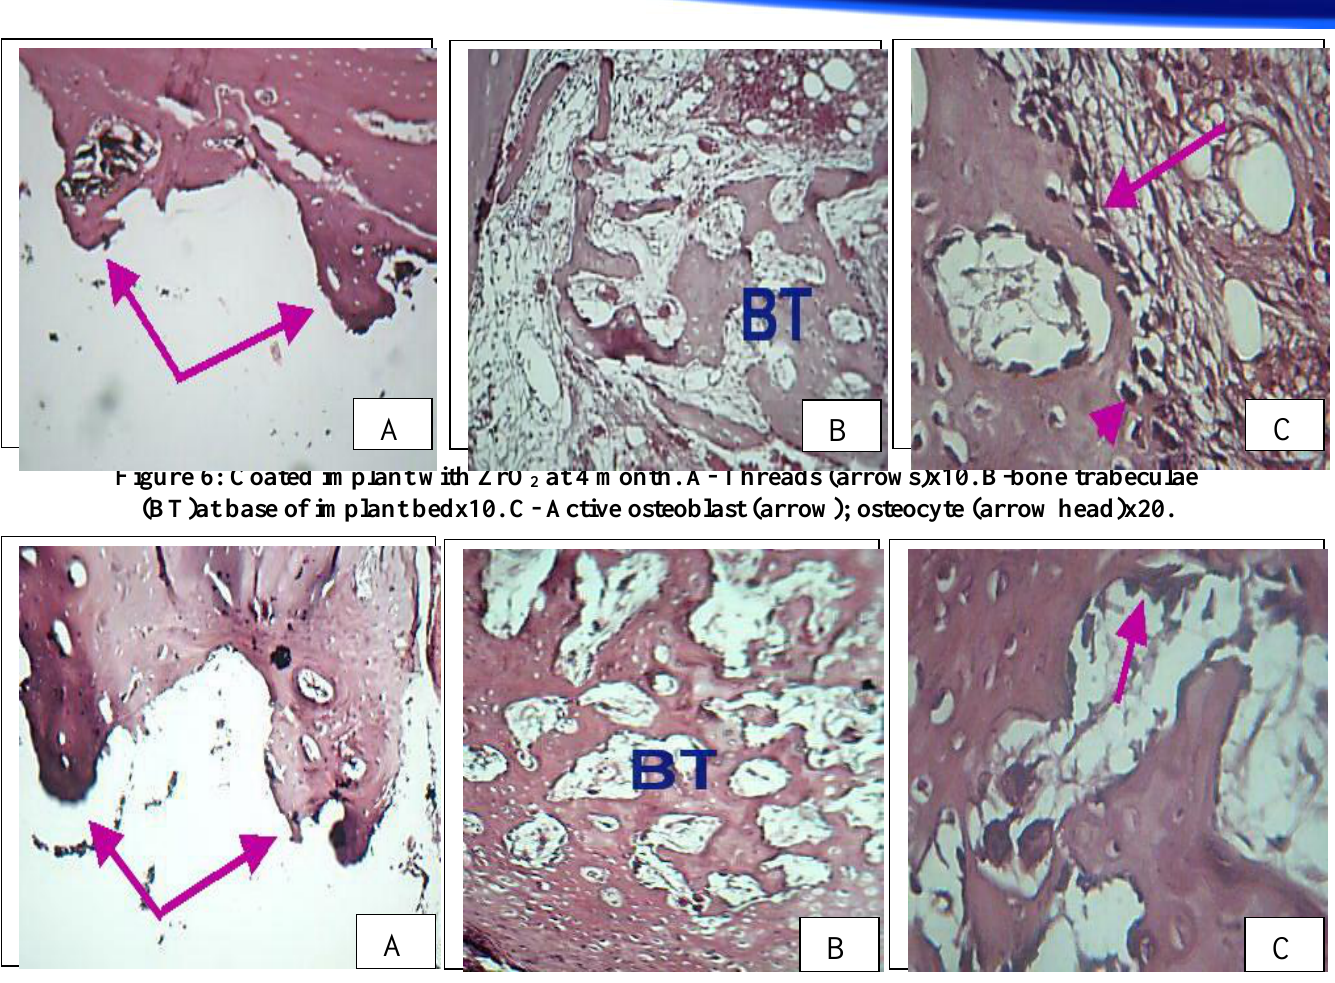
Figure 7: Annealed implant at 4 month. A- Well developed threads (arrows) x20. B-bone trabeculae (BT) filled the base of implant bedx10. C- Bone trabeculae rimming by osteoblast (arrow)